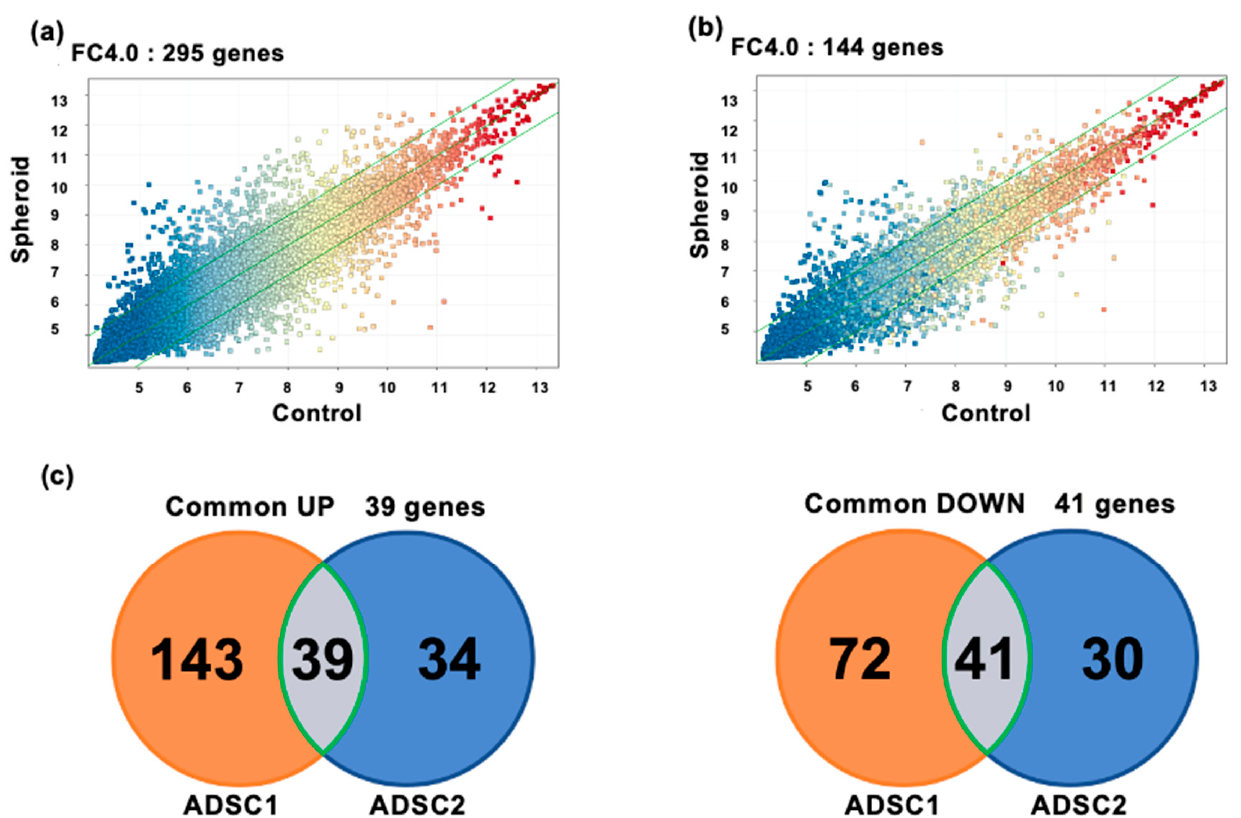
Figure 5. Transcriptome analysis using DNA microarrays. ( a ) Scatter plots of DNA microarray analysis of ADSC1. ( b ) Result of DNA microarray analysis of ADSC2. ( c ) Venn diagram comparing gene expression in spheroid-cultured cells and 2D monolayer-cultured cells showing the number of genes whose expression increased or decreased and the genes that commonly changed in ADSC1 and ADSC2. Common UP shows the number of genes whose expression increased, and Common DOWN shows the number of genes whose expression decreased. In common UP (orange circles), 182 genes were upregulated in both spheroid-cultured and 2D monolayer-cultured ADSC1. In ADSC2, 73 genes were upregulated in both spheroid culture and 2D monolayer culture (blue circles) There were 39 genes that were upregulated in both ADSC1 and ADSC2 (gray circles). In common DOWN, 113 genes in ADSC1 were downregulated in both spheroid and 2D monolayer cultures (orange circle). A total of 71 genes were downregulated in ADSC2 in both spheroid culture and 2D monolayer culture (blue circles). A total of 41 genes were downregulated in both ADSC1 and ADSC2 (gray circles). Table 2. Gene ontology analysis of extracted upregulated genes.